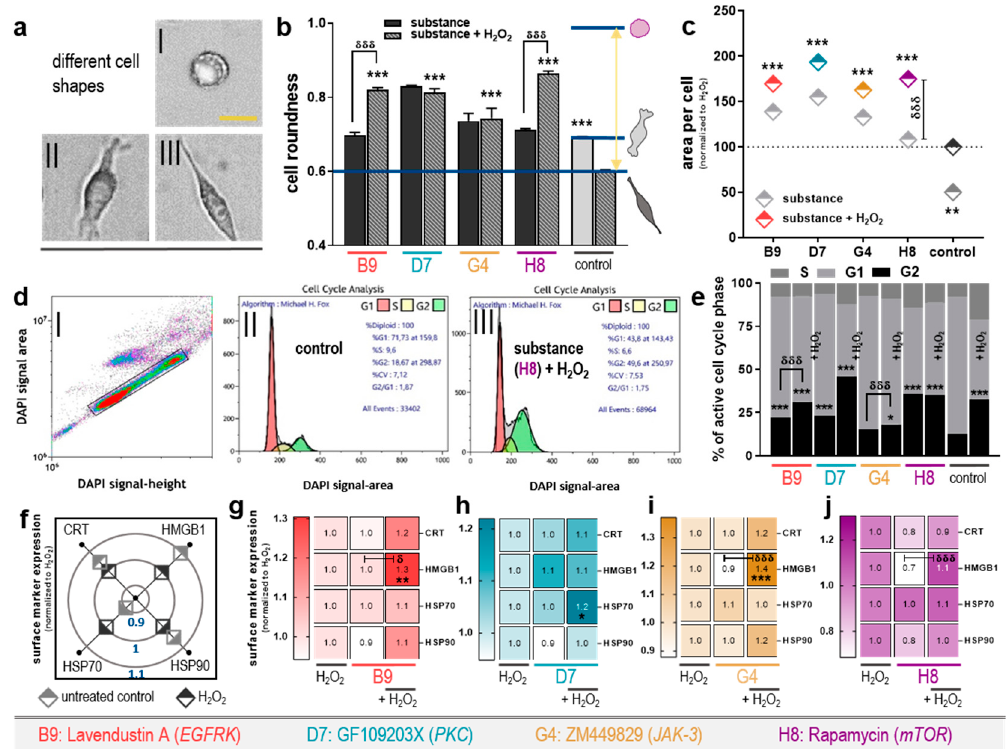
Figure 3. Combination of selected kinase inhibitors with H 2 O 2 led to morphological alterations, cell cycle arrest, and modulated surface marker expression in colorectal cancer cells. ( a ) Representative brightfield images (scale bar = 50 µm) of colorectal cancer cells in a i) round, ii) spindle, or iii) elongated shape; ( b ) quantification of the cells’ roundness +SEM; and ( c ) area per cell 24 h post incubation with selected kinase inhibitors (+/- H 2 O 2 ); ( d ) i) representative gating of DAPI signal (amount of nuclear acid) and the algorithm-based analysis of cell cycle phases of ii) untreated control cells, or ii) cells that received substance H8 + H 2 O 2 ; ( e ) quantification of cell cycle phases and comparison of the percent of cells in the G2-phase; ( f ) modulation of the surface expression of calreticulin (CRT), high-mobility group box 1 protein (HMGB1), and the heat-shock proteins (HSPs) 70 and 90 in cells that were left untreated or received H 2 O 2 alone for 24 h (inner ring fold change = 0.9; middle ring: no change; outer ring: fold change = 1.1); analysis of these surface markers on cancer cells that were incubated with the substances ( g ) B9, ( h ) D7, ( i ) G4, or ( j ) H8 with or without H 2 O 2 for 24 h (blank fileds = decrease in marker expression). Significance levels for the comparison of substances without H 2 O 2 to the respective substances with H 2 O 2 ( δ ), and of their combination (with H 2 O 2 ) to the H 2 O 2 -alone control (*) were determined via ANOVA. Data are representatives out of two independent replicates.